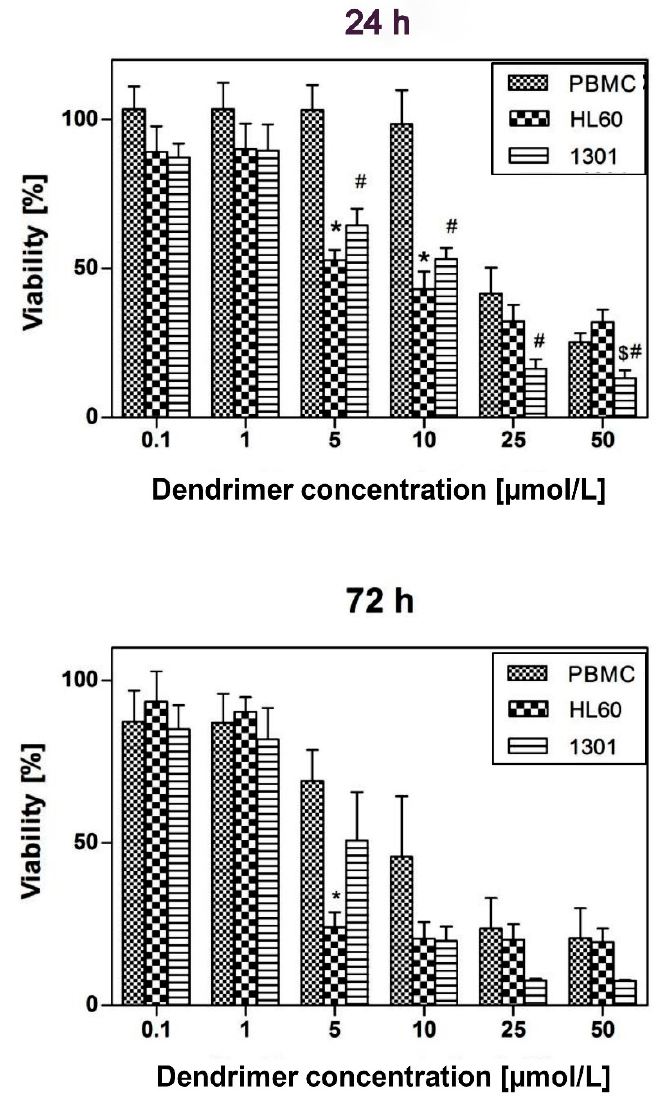
Figure 7. Effect of ruthenium terminated carbosilane dendrimer with FITC (CRD13-FITC) on the viability of PBMC, HL-60 and 1301 cells after 24 h and 72 h incubation. The values are the mean ± SD, n = 9. Statistically significant differences in comparison to the control cells (* p <0.05, # p <0.01, $ p <0.001).